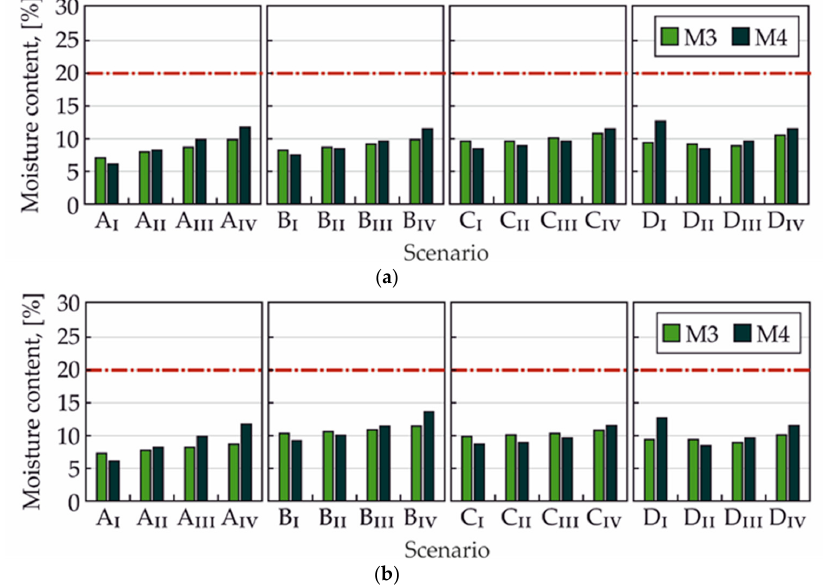
Figure 8. Maximal moisture content for CLT (M3 and M4) for ACH = 3 h − 1 ( a ) and ACH = 9 h − 1 ( b ).